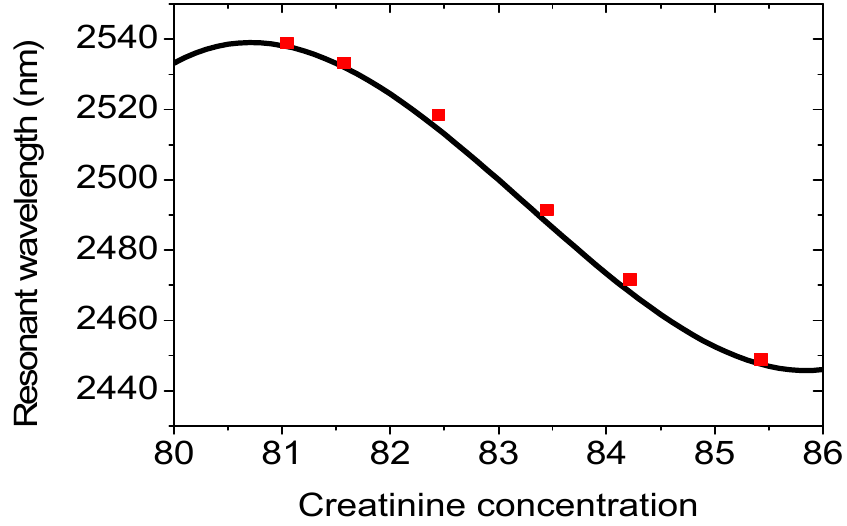
Figure 10. Resonant wavelength versus creatinine concentration for a ternary photonic crystal at θ 0 = 60°, h f = 5.5 µm, and N = 4.